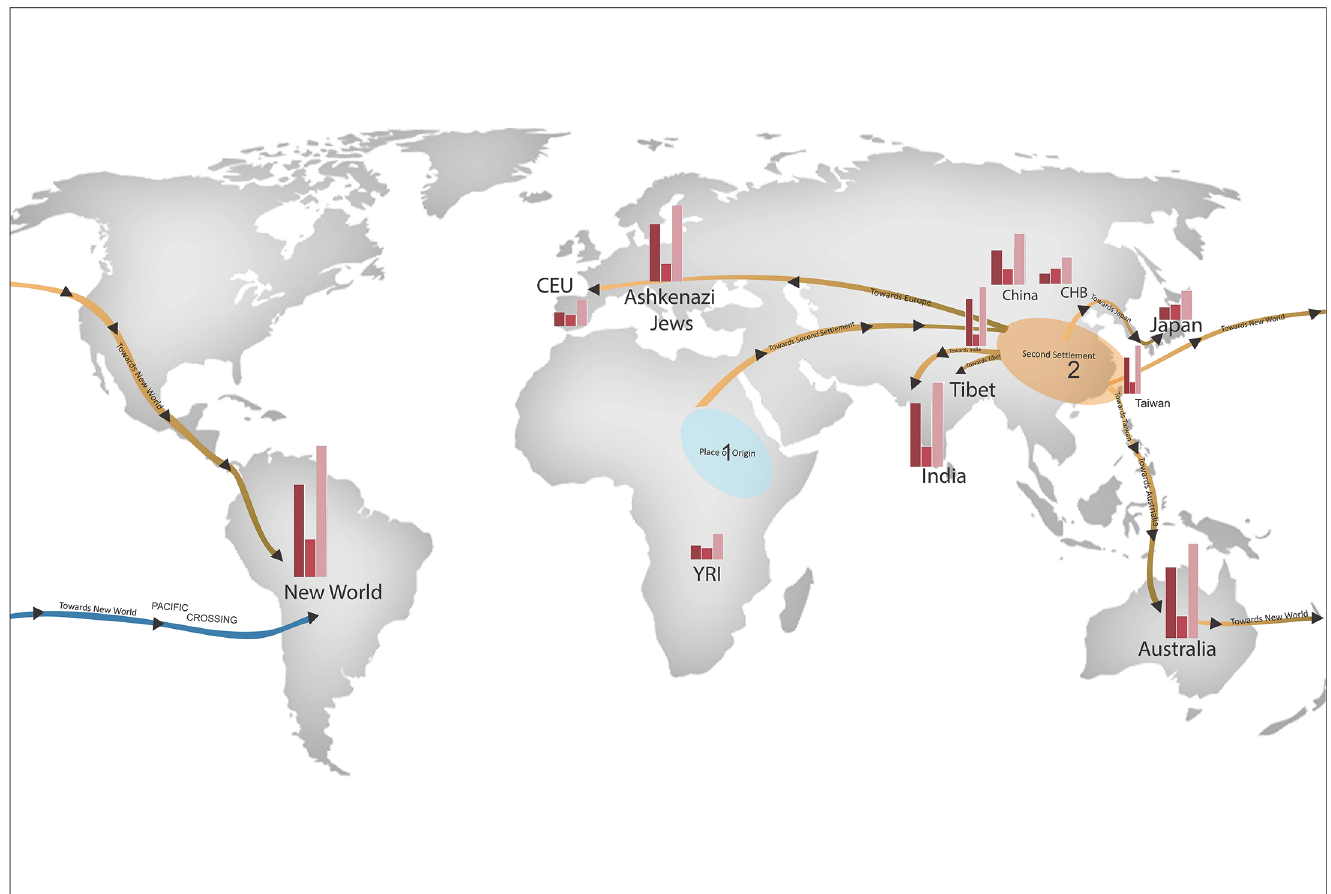
Fig 4. A global map showing the CNV counts of populations taken in the study and the possible migration routes. Anatomically modern humans evolved from Africa formed the first settlement which branched further towards the second settlement (SS) forming the present day east China and Taiwan regions. This SS showed increased number of shared genomic signatures with the further branched populations such as Tibet, India, Japan, Taiwan, and Australia towards the east, while Ashkenazi Jews and CEU towards the west. More than 5 branches emerged from the SS at varying time points and with varying founding members, namely SS to Tibet, SS to India, SS to Europe, SS to Japan, and SS to Taiwan. Bar graphs indicate genome-wide distribution of duplication CNVs (1st Bar), deletion CNVs (2 nd Bar) and CNV (3rd Bar) consists of both duplication and deletion events across 12